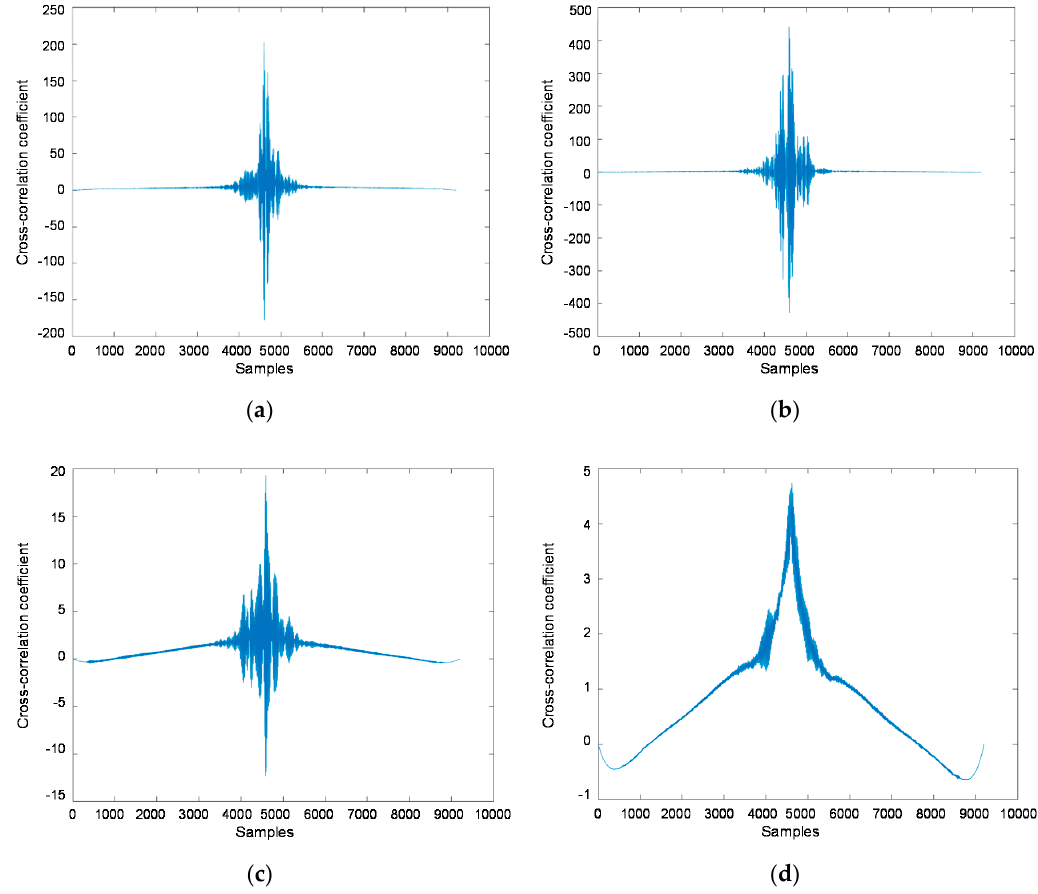
Figure 7. Cross-correlation between adjacent signals of damaged WTB: ( a ) 200–300 mm; ( b ) 700–800 mm; ( c ) 2,300–2,400 mm; and ( d ) 2,900 and 3,000 mm.